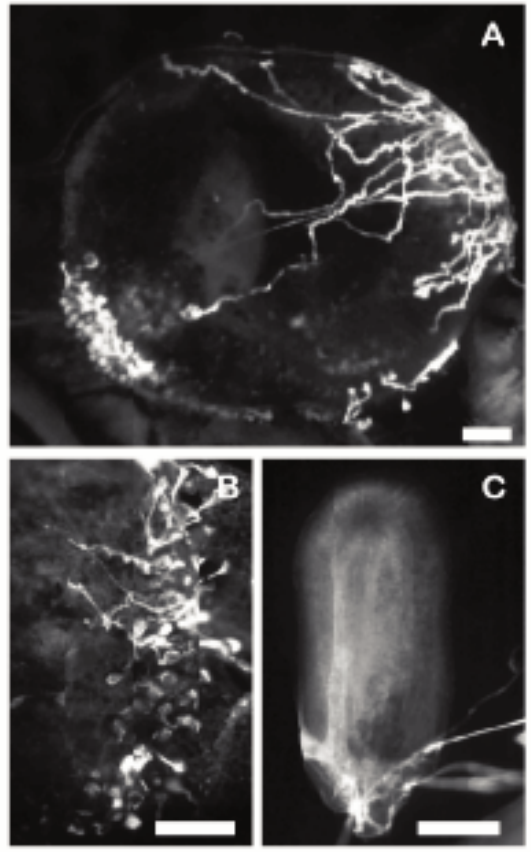
Fig. 6 -Fluorescent light micrograph of pollen tube germinated on pistils of B. microphylla G. Forst. A, view of stigma with pollen grain germinated and pollen tubes inserted in the ovary; B, pollen tubes on the first stage of growth; C, pollen tube penetrating the ovule. Bars: A-C= 100